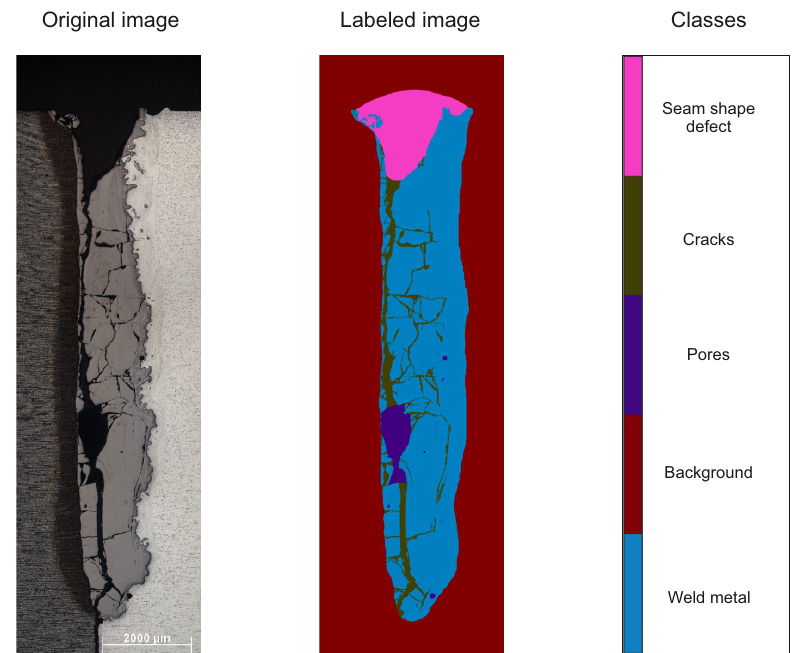
Figure 2. Original image, labeled image and class